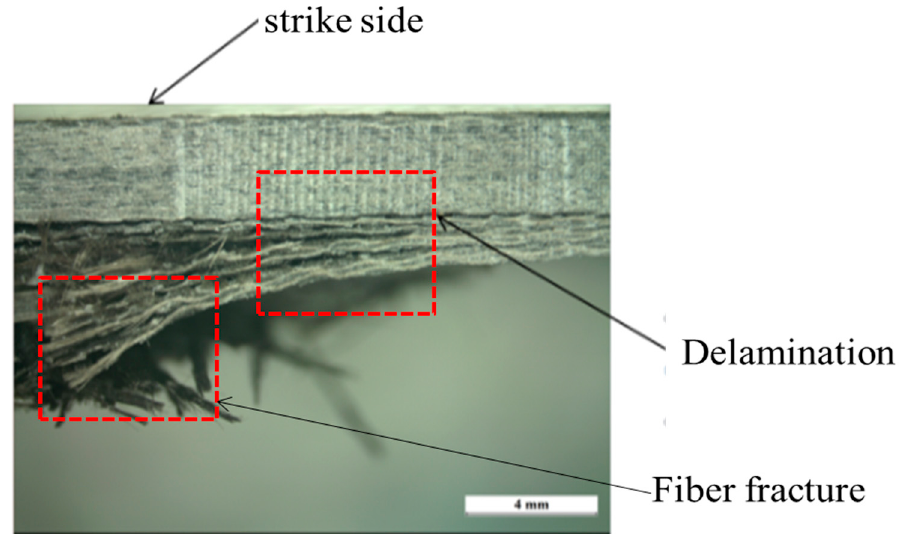
Figure 1. Cross-section of basalt-epoxy laminate after being subjected to 40 g TNT and 200 mm SOD [9].